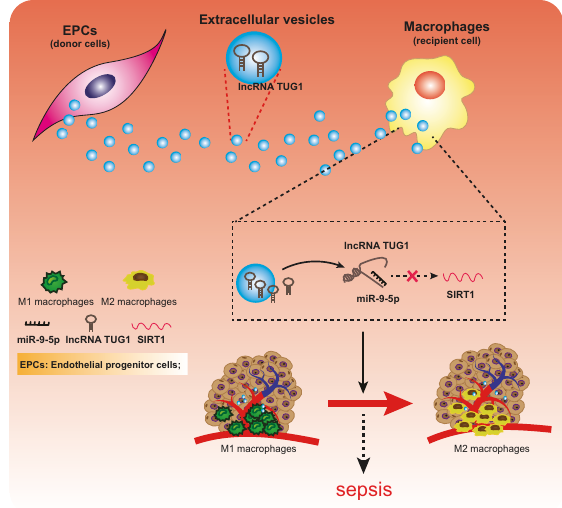
Fig. 8 Schematic representation and function of TUG1 /miR-9-5p/ SIRT1 axis in the regulation of macrophage polarization in sepsis. EVs encapsuled TUG1 from EPCs stimulated the M2 macrophage polarization and inhibited in fl ammation by upregulating SIRT1 expression through inhibition of miR-9-5p to prevent the develop- ment of